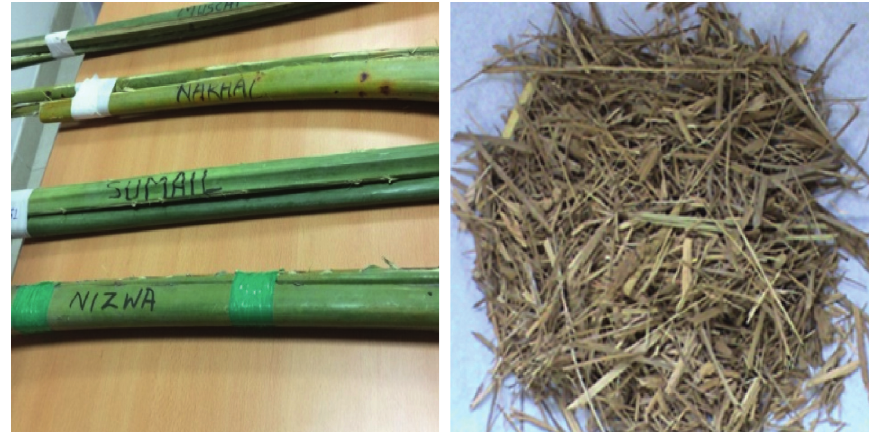
Figure 1: Date palm fibers.